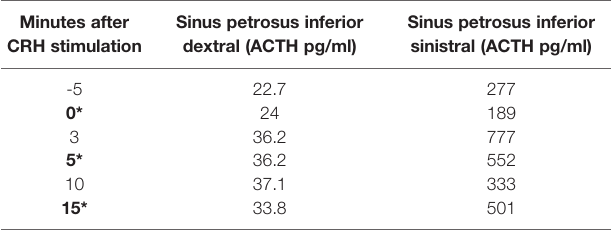
TABLE 2 | Bilateral inferior petrosal sinus sampling ACTH levels.